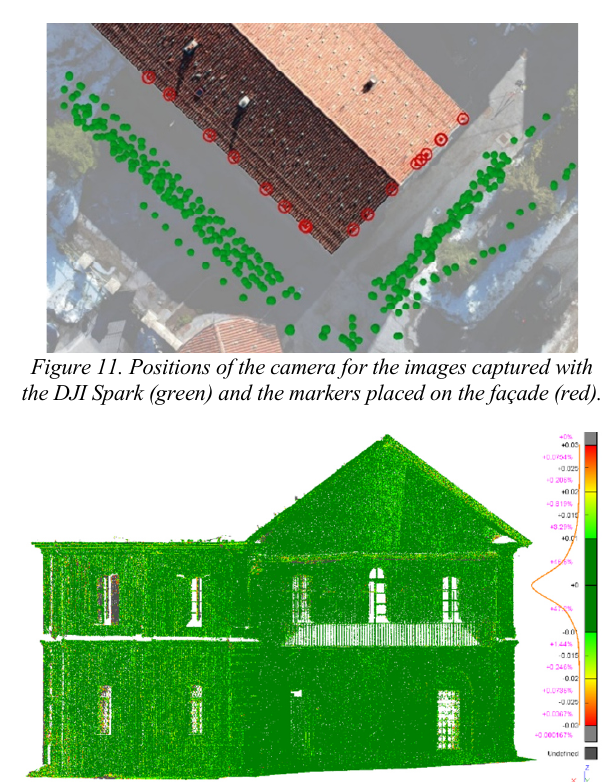
Figure 10. C2C comparison between the X 330 point cloud (ground truth) and the DJI Spark for an absolute distance < 30 mm.